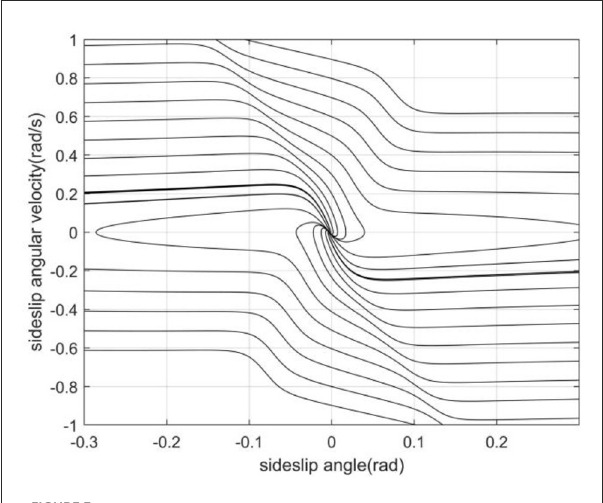
FIGURE3 Phase plane trajectory with road adhesion coefficient 0.2, longitudinal speed 11 m/s and front wheel angle 0 ◦